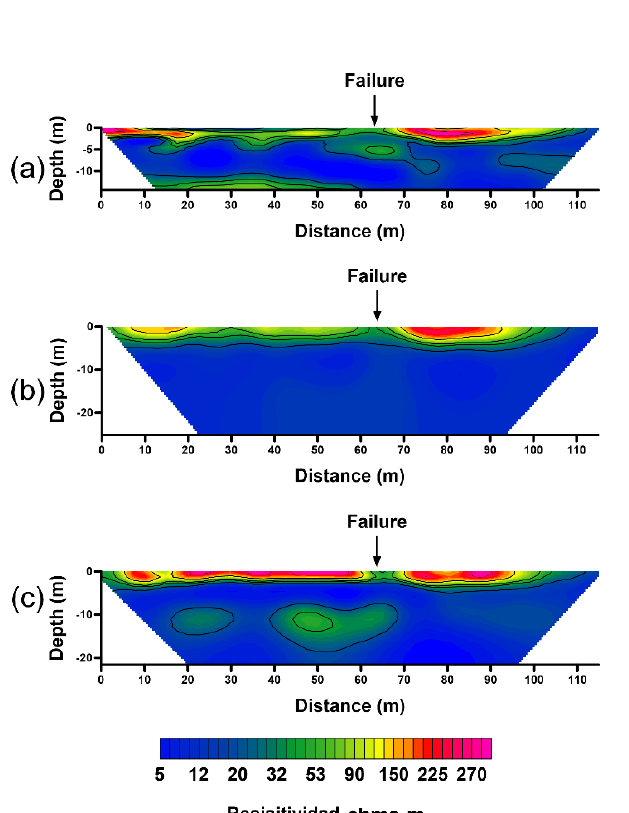
Figure 1. Location study site (© Google Earth).